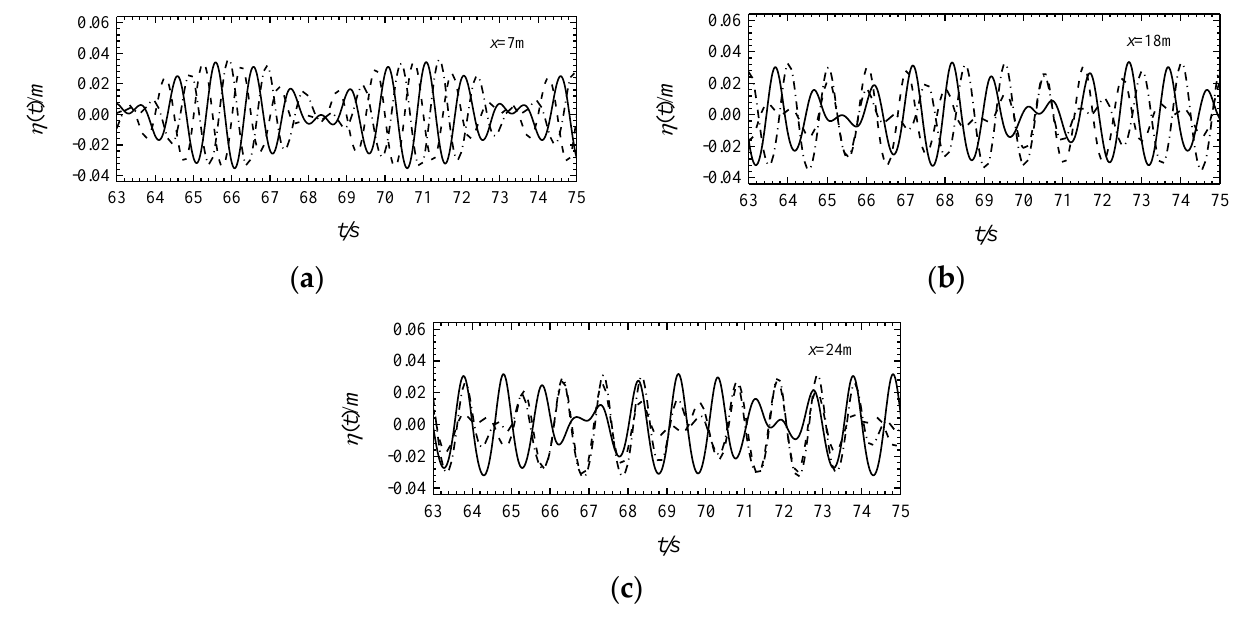
Figure 20. Comparison of wave surfaces at three points x = 7 m (a), 18 m (b), and 24 m (c) of MIKE 21 BW model with dual-frequency waves in downstream (dotted line), no-current (solid line), and counter-current (dotted line).